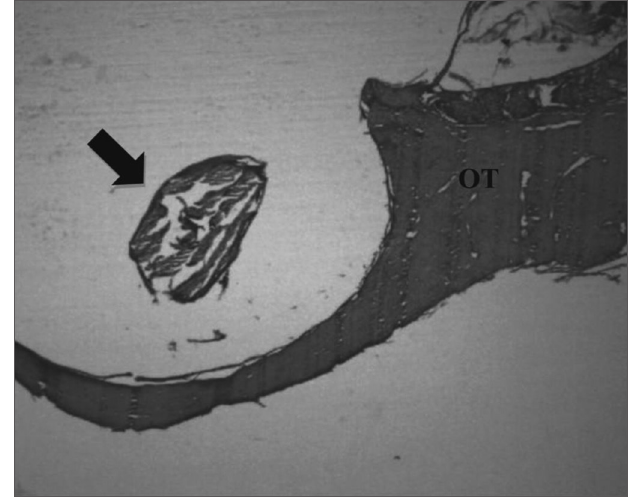
Figure 4. Experimental group with 12 weeks - Microphotography of the sugar cane biopolymer membrane; on the tympanic bulla without signs of inflammatory reaction. OT= temporal bone; broad arrow = sugar cane biopolymer. HE (40x